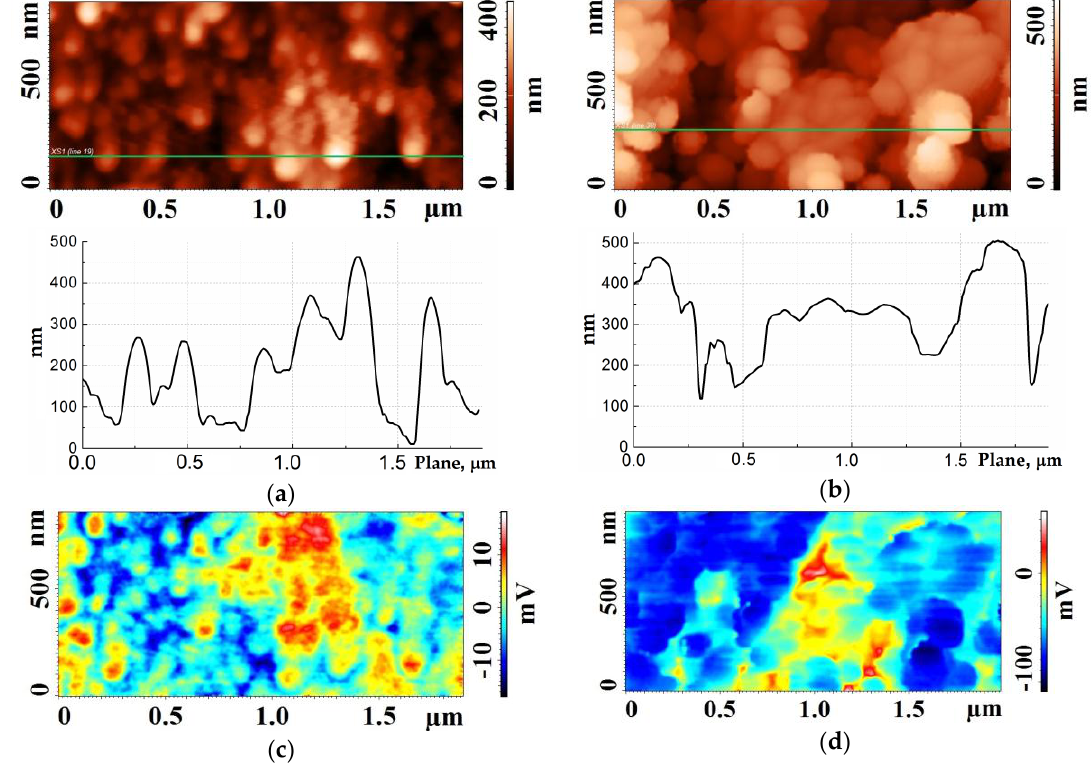
Figure 4. AFM scanning of the surface potential of elastically strained CNTs: ( a , b ) topology of the surface (top) and cross section along the line (bottom) of sample A and sample B, respectively; ( c , d ) potential distribution of sample A and sample B, respectively.